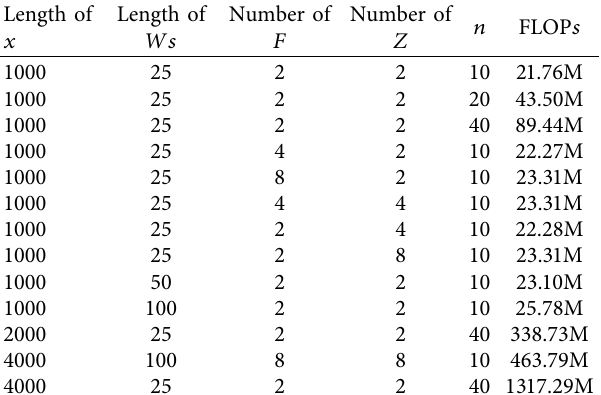
Table 1: The computational complexity (FLOPs) under different